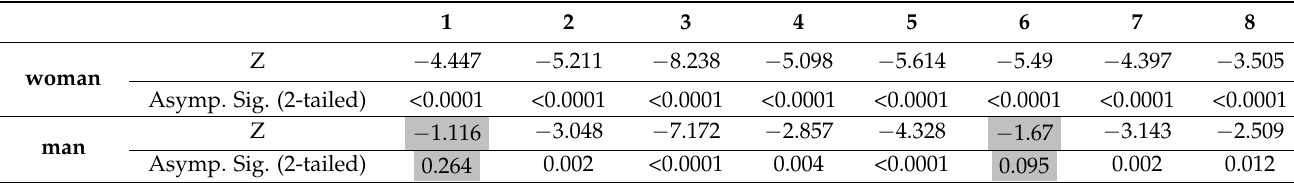
Table 7. Gender-based consumer attitudes.